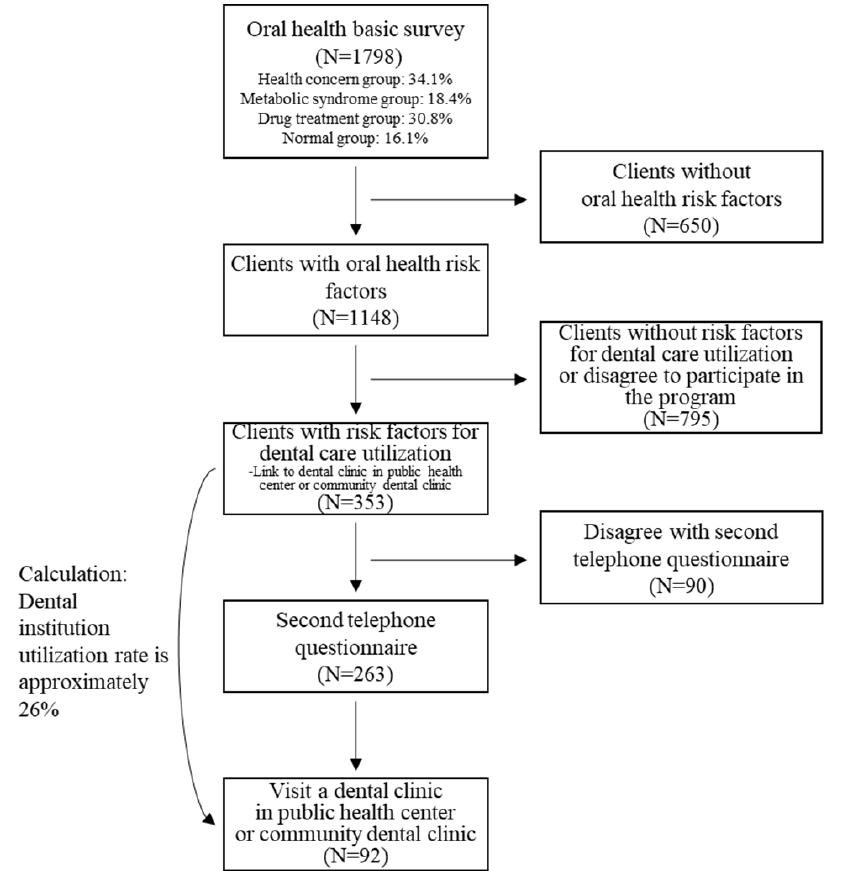
Figure 2. Monitoring flow of the oral health management and NCDs preventive management project. Table 1. General characteristics of